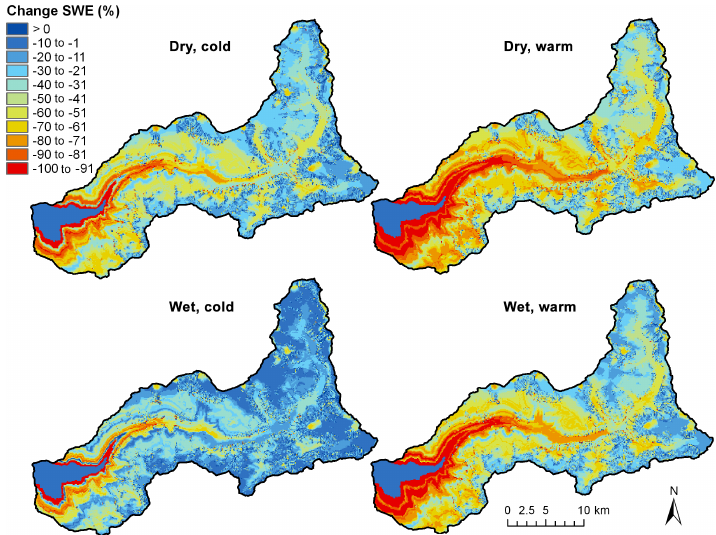
Figure 8. Change in SWE averaged over the simulation period and all members for each climate sensitivity test (Table 3).